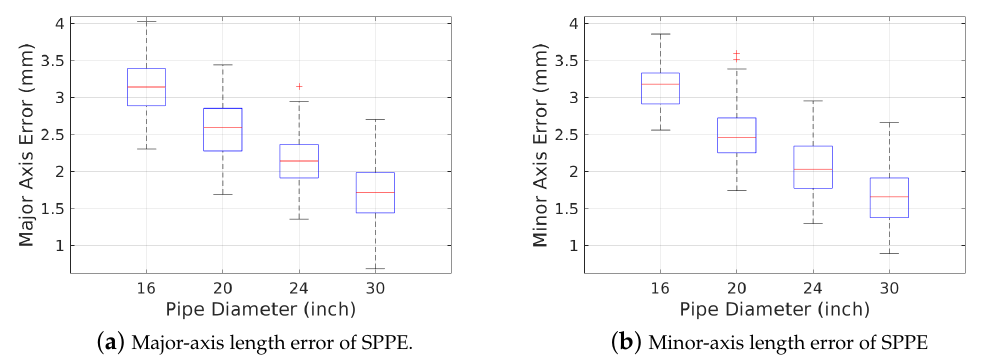
Figure 11. Major- and minor-axis length errors of our SPPE for different pipe diameters.